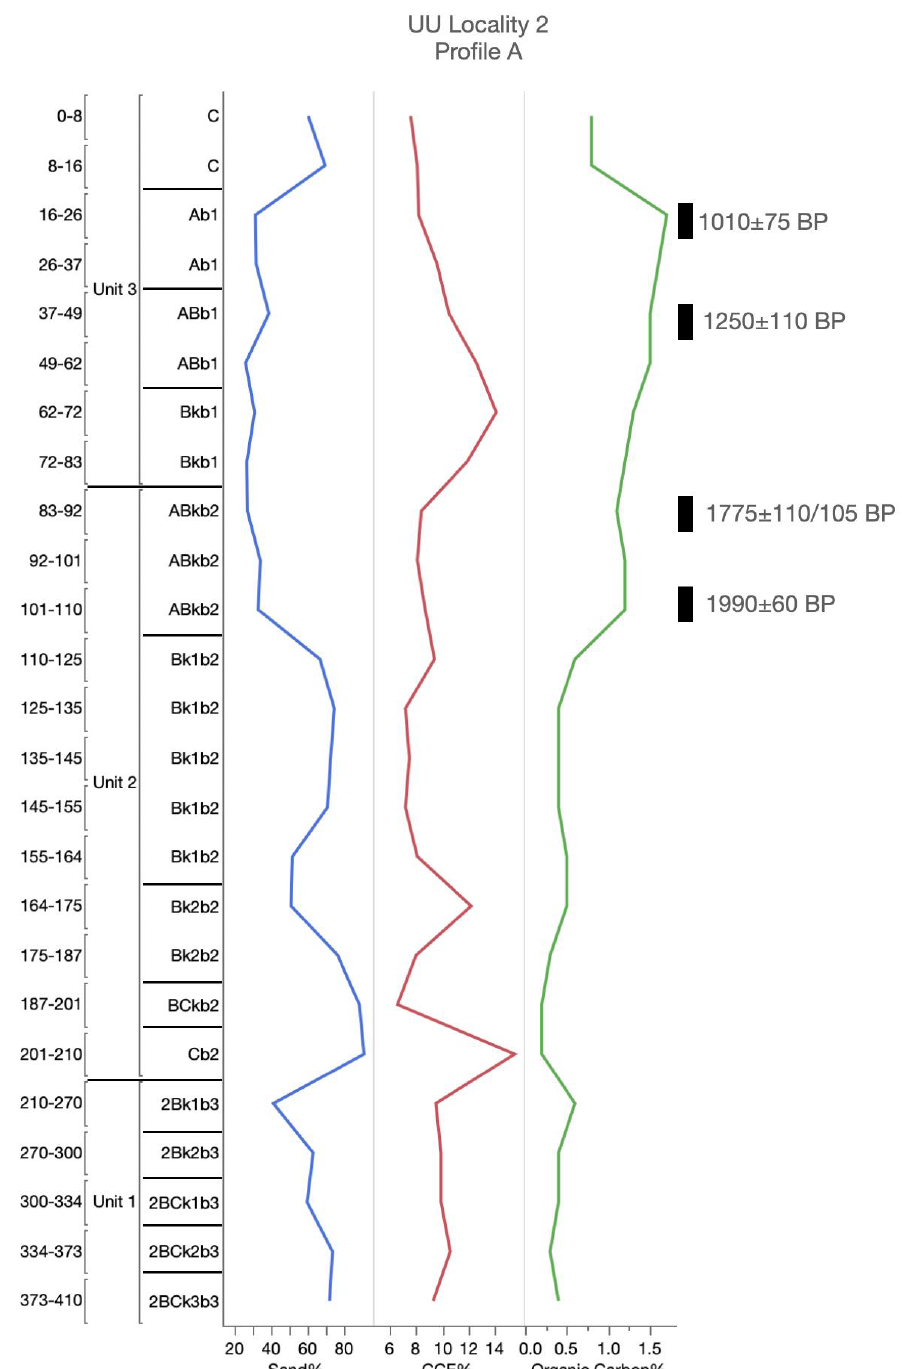
Figure A15. Accepted radiocarbon ages and soil and sediment analysis at UU Locality 2, Profile A—Post research area, northwest, Texas. CCE = calcium carbonate equivalence.